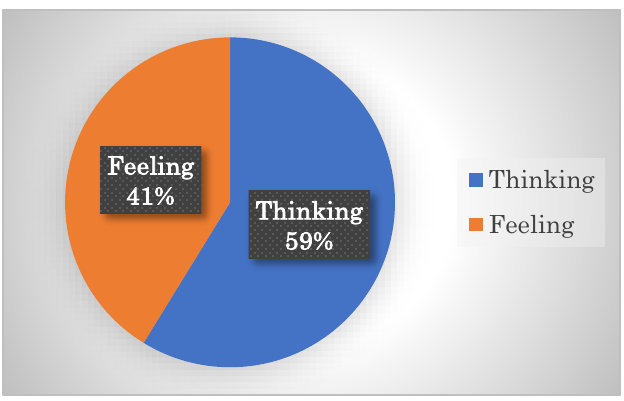
Fig. 4. Distribution of Class C in a dataset